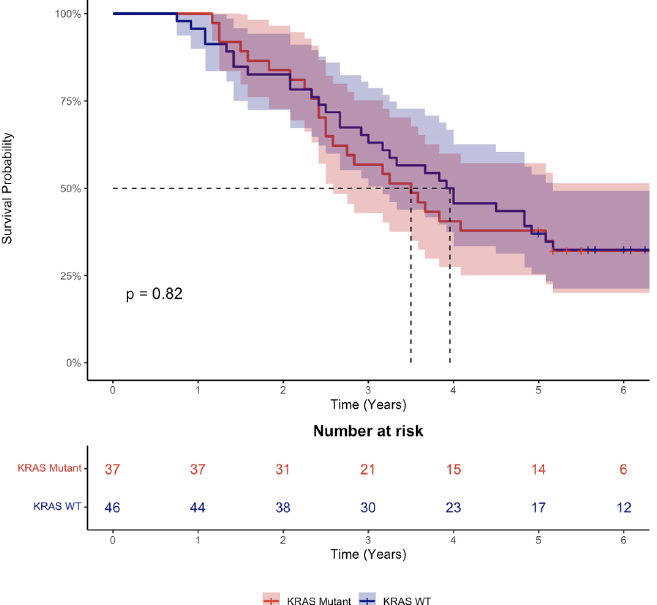
Figure 1. Kaplan–Meier graph of survival by KRAS mutation status. Data are presented as median Figure 1. Kaplan – Meier graph of survival by KRAS mutation status. Data are presented as median with 95% confidence interval. with 95% confidence interval.